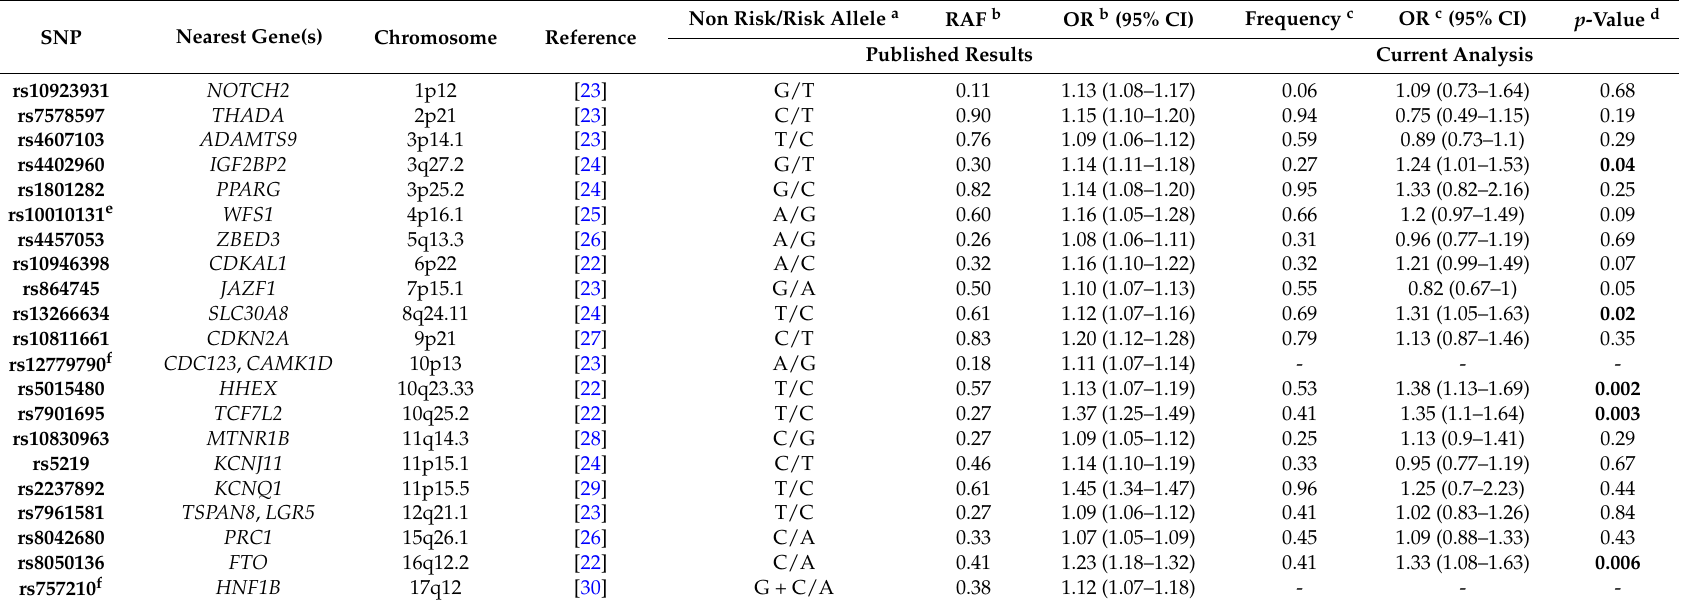
Table 2. Summary of the single nucleotide polymorphisms (SNPs) included in the